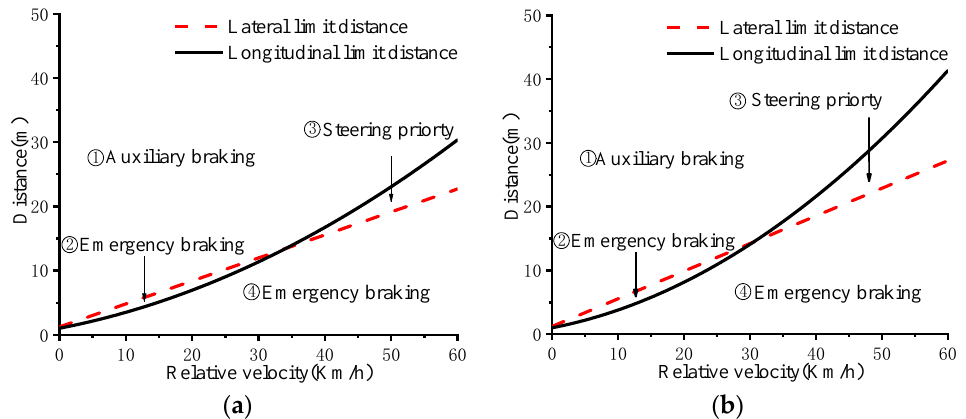
Figure 5. The choice of active collision avoidance during an emergency in different environments: ( a ) Dry asphalt pavement (μ = 0.8); ( b ) Wet asphalt pavement (μ = 0.5). Longitudinal lateral collision avoidance agents are plotted in Figure 5a,b. The mini- mum safety distance required for emergency longitudinal collision avoidance is related to the square of the vehicle speed, and the minimum longitudinal safety distance required for emergency lateral collision avoidance is related to the square of the vehicle